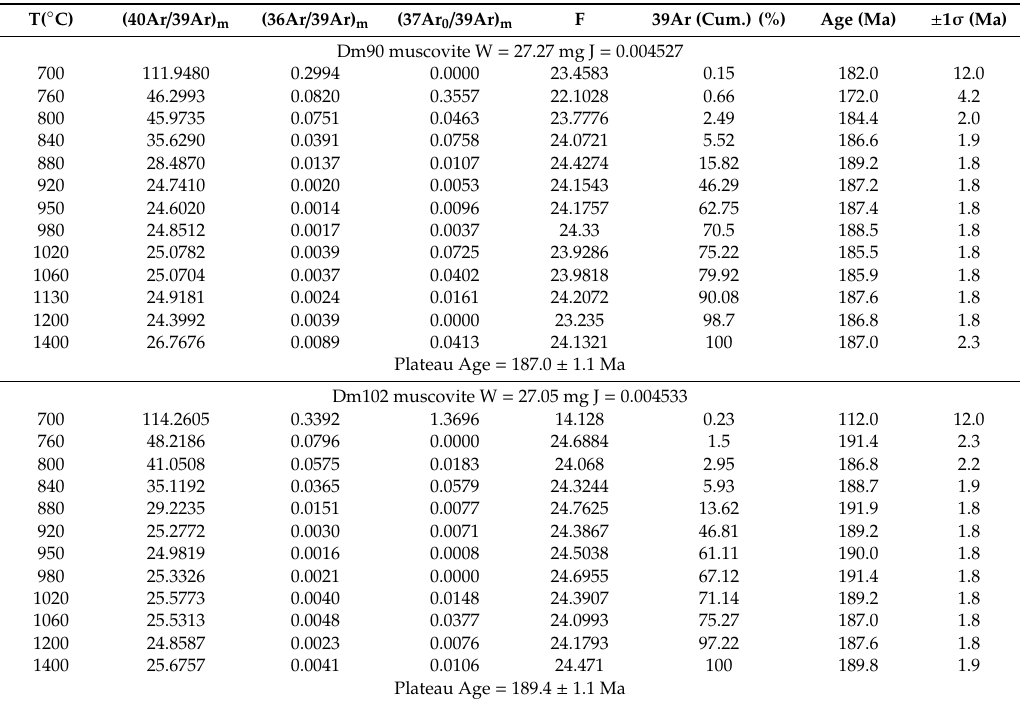
Table A1. 40 Ar / 39 Ar step-heating data for muscovite samples extracted from the spodumene pegmatites of the Dahongliutan, Zhawulong, and Ke’eryin ore